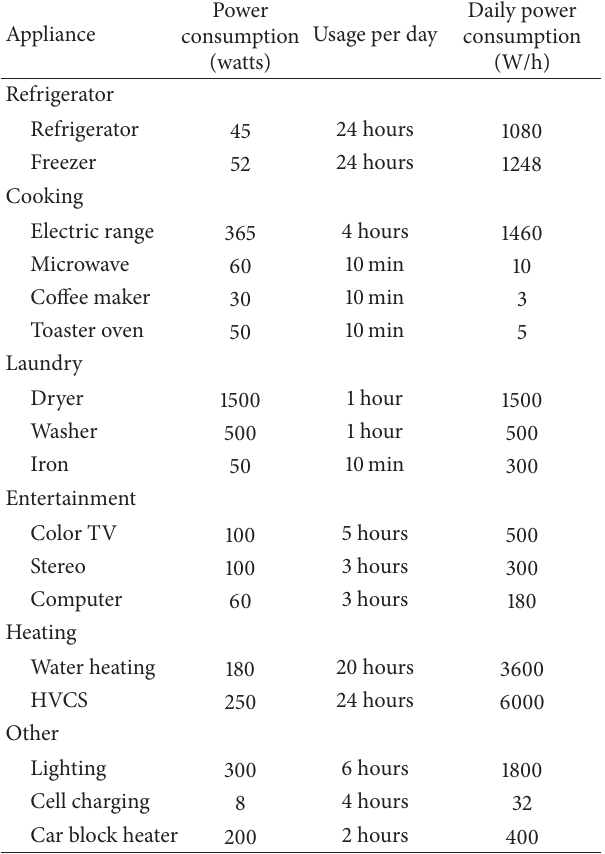
process the input of price and load and generate output which will be sent as a control signal to operate grid switch and storage switch.